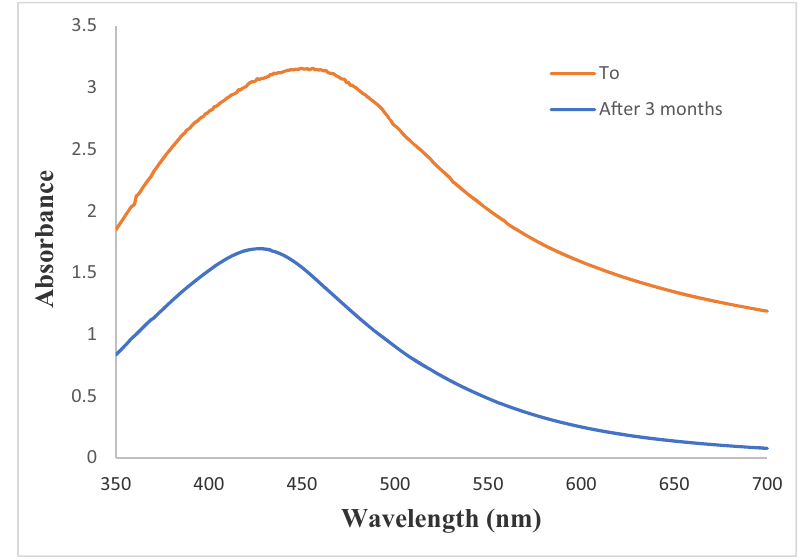
Figure 10: UV – Vis spectra of microalgae biomass - mediated AgNPs ’ synthesis with 1 g · L − 1 of AgNO 3 at 50 s of microwave exposure before and after 3 months of